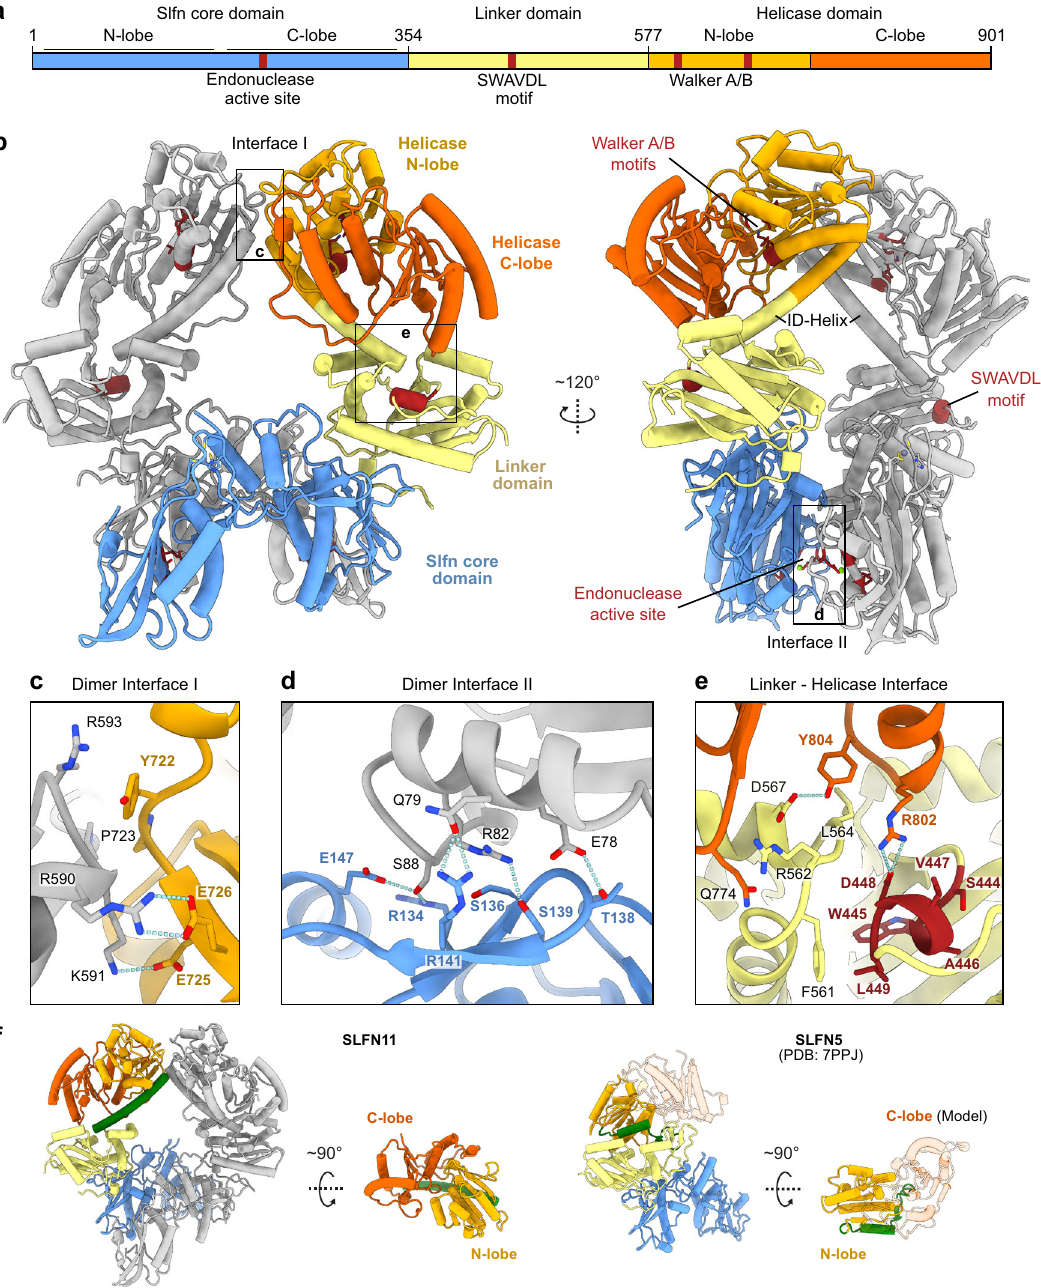
Fig. 1 | Structure of full-length human SLFN11. a Domain architecture of SLFN11 with indicated key functional features. b Ribbon representation of the full-length humanSLFN11dimerwithhighlightedstructuralfeaturesindarkred. c Detailedview of the dimer interface I between helicase domains. d Detailed view of the dimer interface II between Slfn core domains. e Detailed view of the linker-helicase